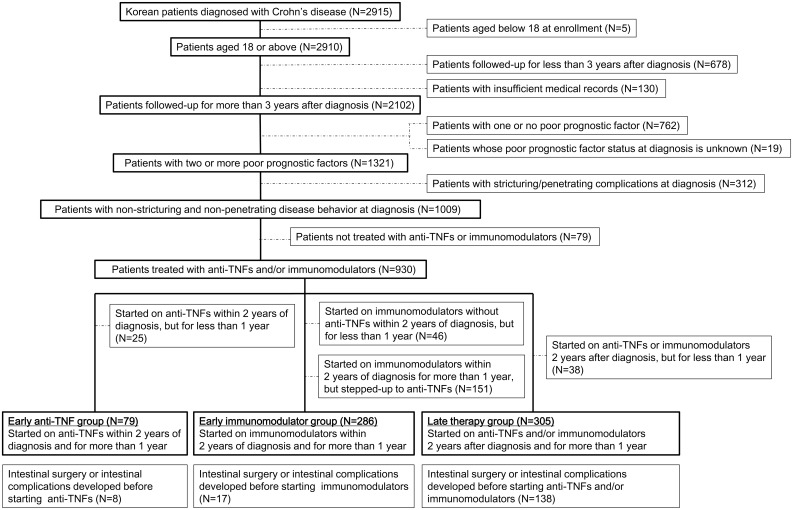
Patient flow diagram.